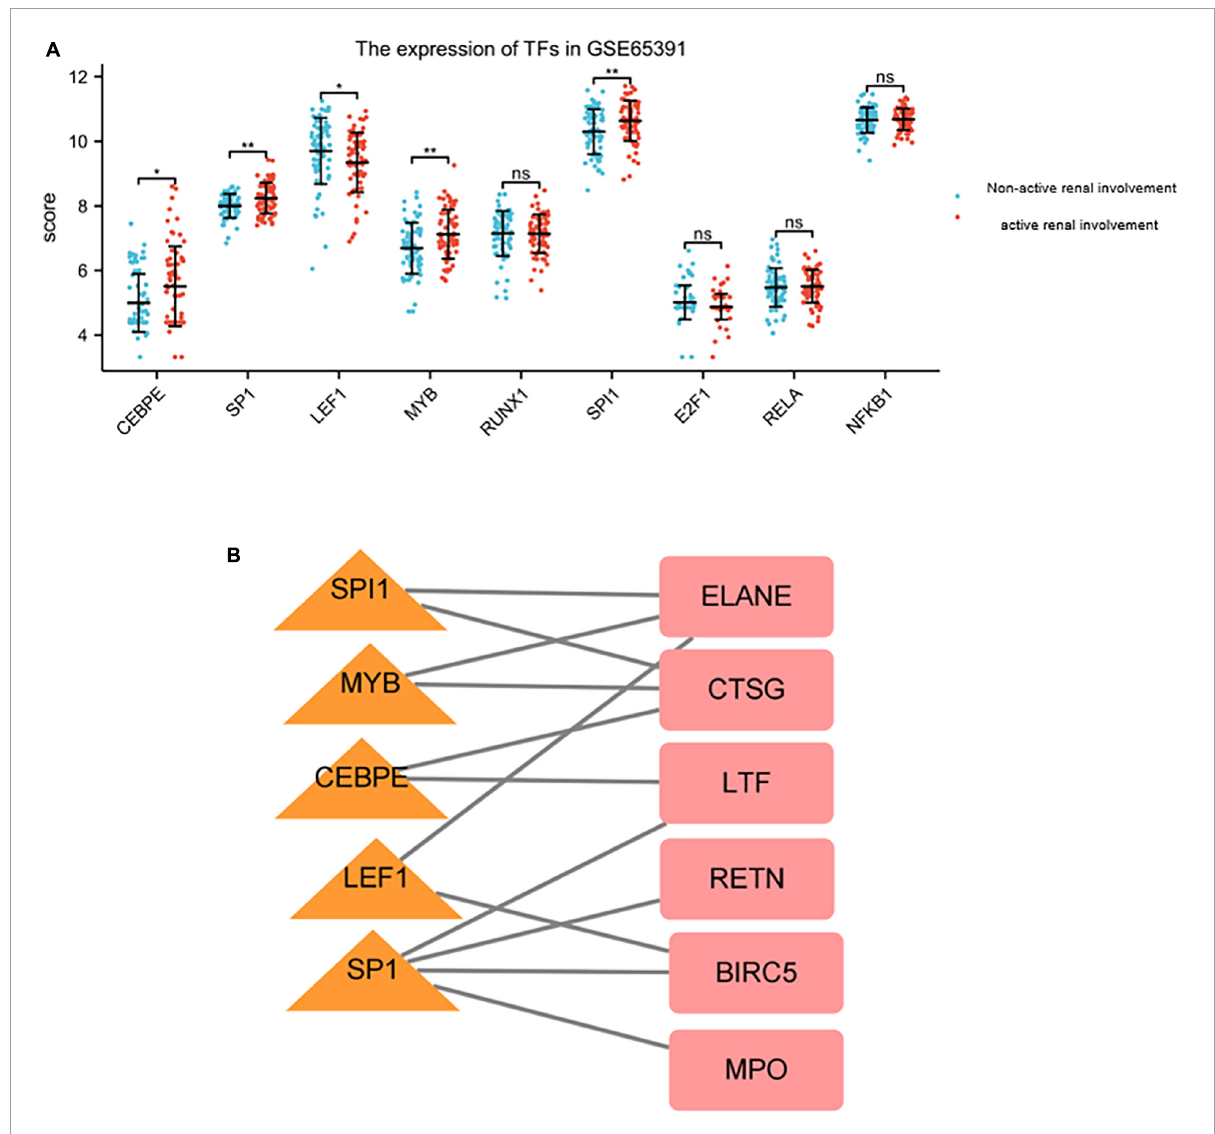
FIGURE9 The expression of TFs in GSE65391 and TFs regulatory network. (A) The expression level of TFs in GSE65391. The expression of five TFs, namely SPI1, MYB, CEBPE, LEF1, and SP1 were validated by GSE65391. * P < 0.05, ** P < 0.01. (B) The verified TF regulatory network. TFs were marked in yellow triangle, and the hub genes were marked in red